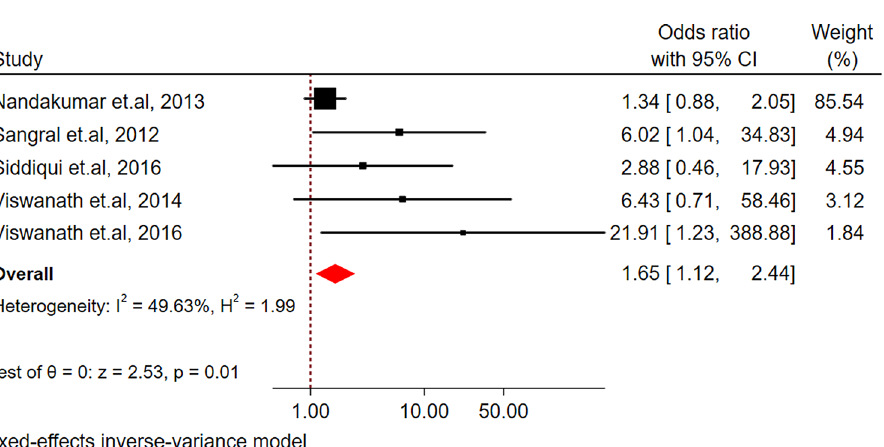
Figure 3. Forest plot for the association between diabetes and treatment failure among tuberculosis patients in South